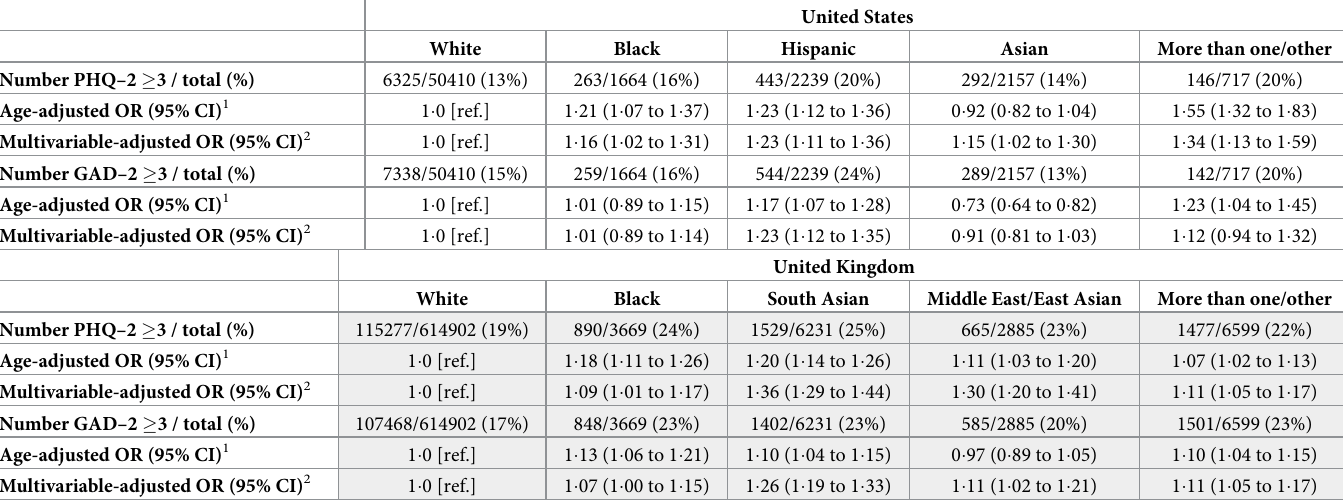
Table 2. PHQ and GAD scores by race and ethnicity according to country of